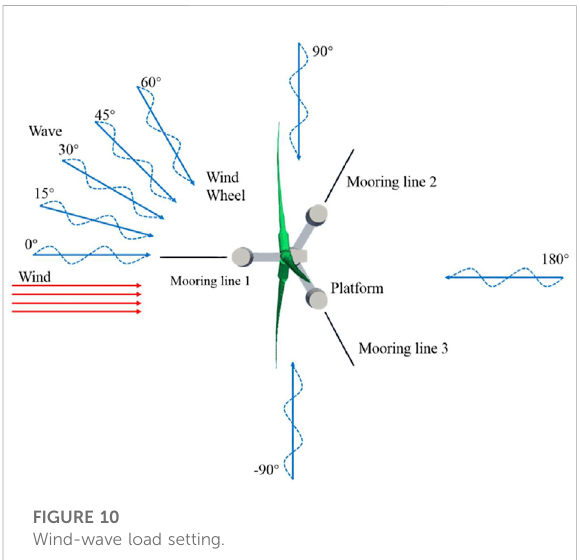
FIGURE 10 Wind-wave load